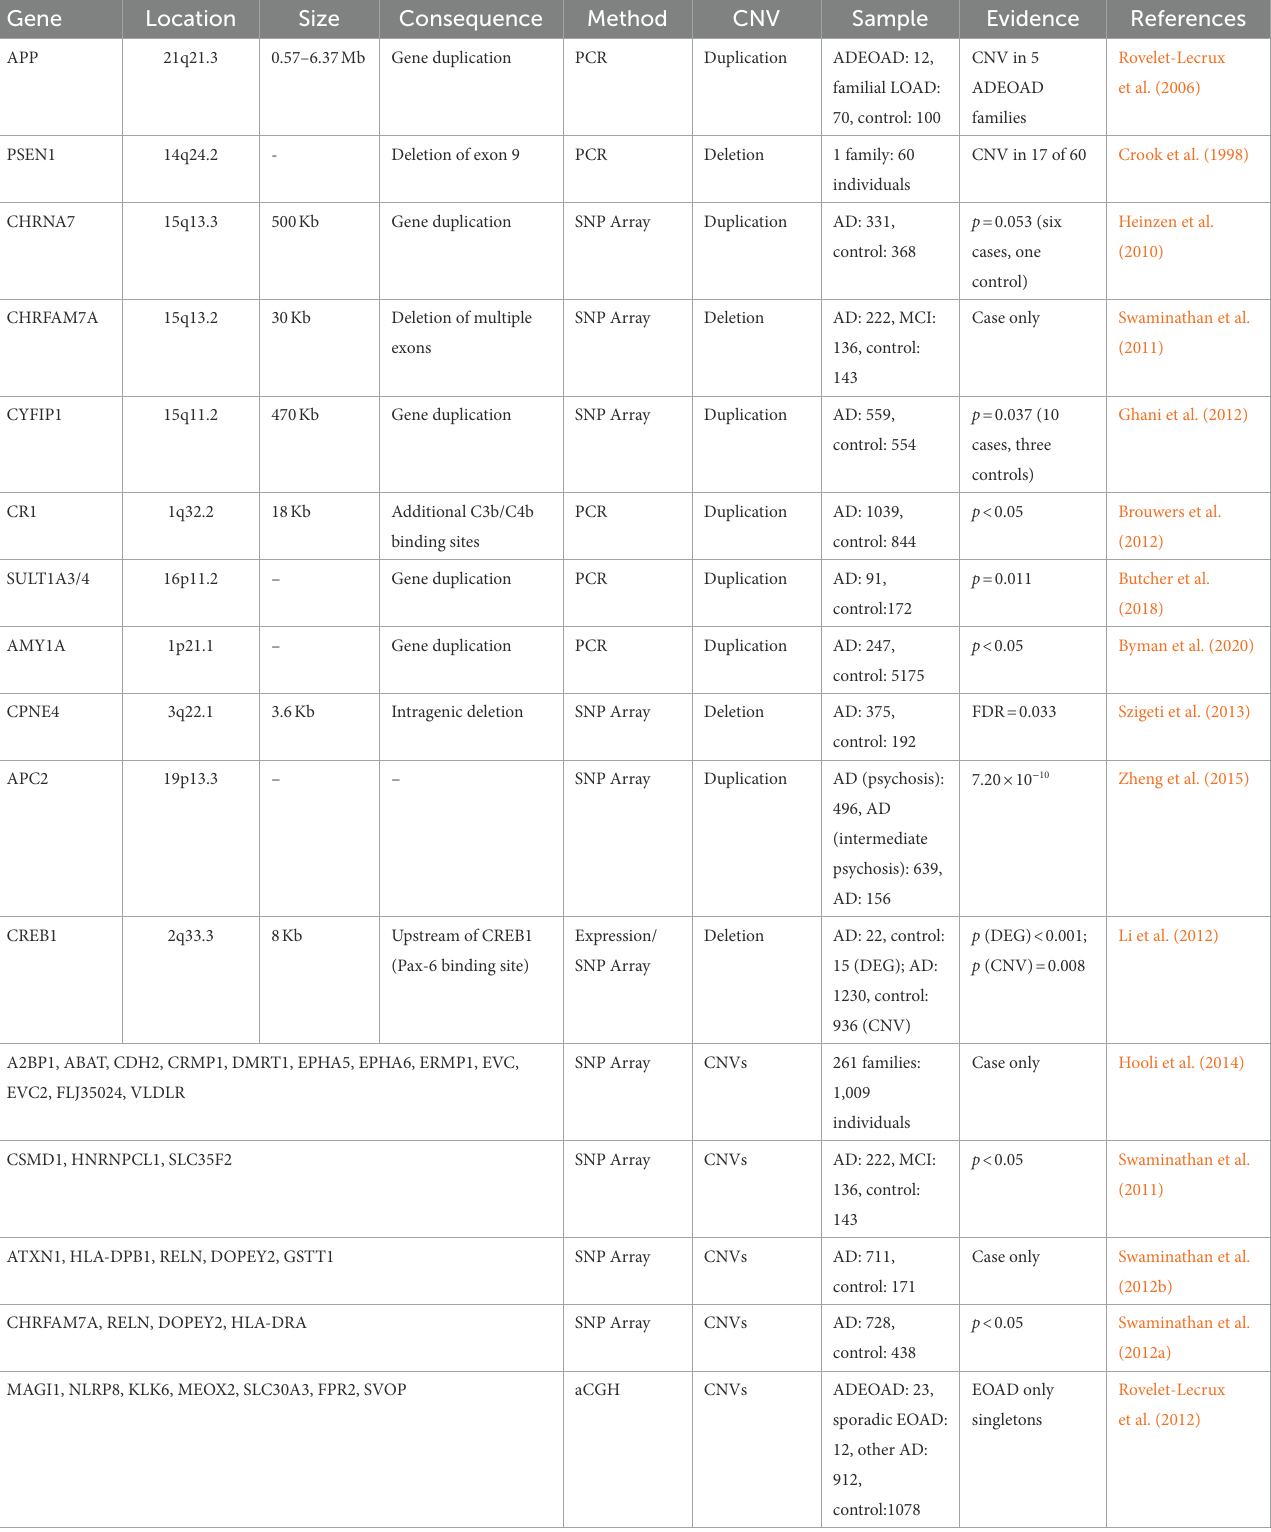
TABLE 1 Copy number variants associated with Alzheimer’s disease.